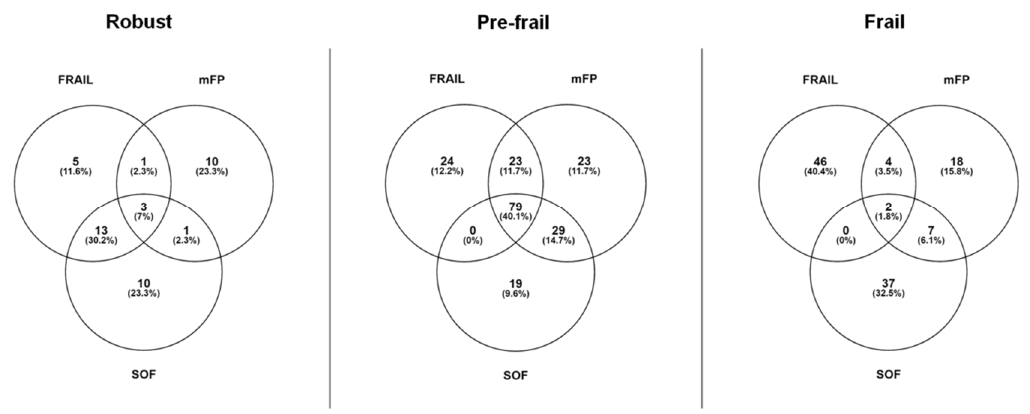
Figure 1. Venn diagram showing the extent of overlap of frailty categories among the three frailty screening tools used. Abbreviations: mFP, modified frailty phenotype; SOF, Study of Osteoporotic Fractures.